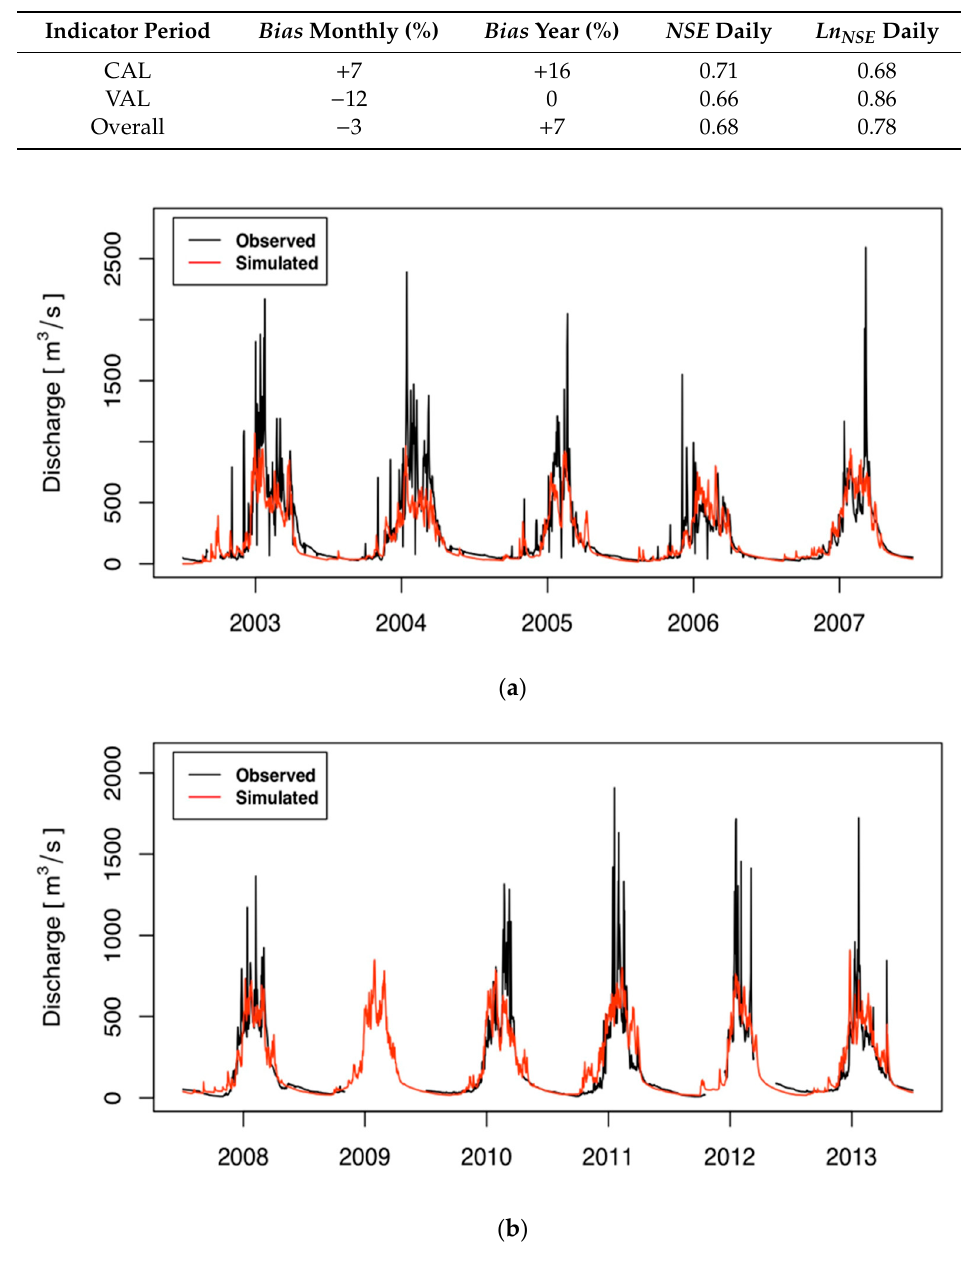
Figure 4. Observed and simulated daily flow using Poli-Hydro at Rabuwa Bazar. ( a ) CAL . ( b ) VAL .